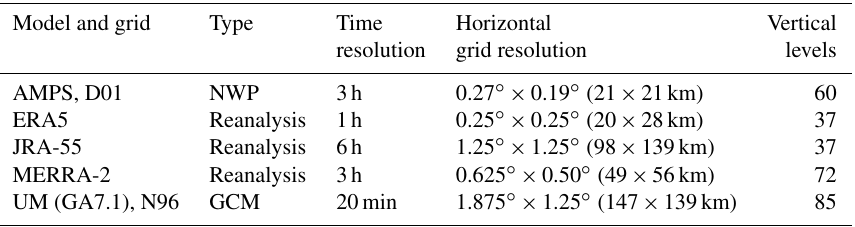
Table 2. Reanalyses and models used in the case studies and some of their main properties. The temporal and horizontal grid resolution and vertical levels listed indicate the resolution of the model output available. The horizontal grid resolution is determined at 45 ◦ S. The internal resolution of the model may be different (see Sect. 3.2 for details). The reanalyses and the UM use regular longitude–latitude grids, while the AMPS horizontal grid is regular in the South Pole stereographic